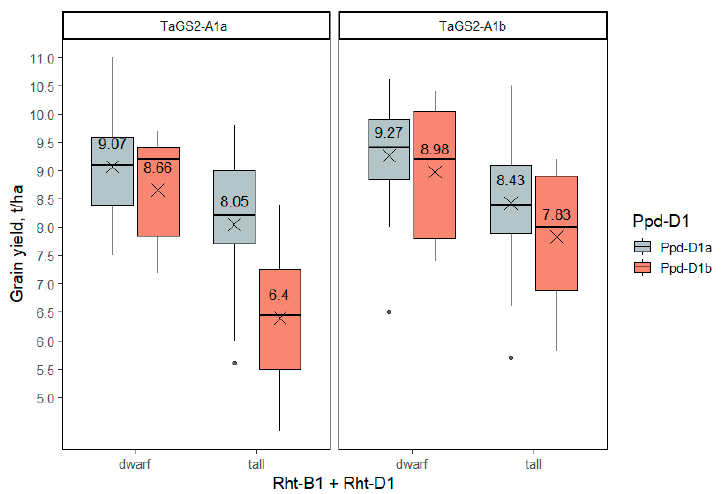
Figure 5. The grain yield of wheat accessions differing in genotypes of the three groups of genes— Rht-B1 + Rht-D1 , Ppd-D1 , TaGS2-A1 . The dots indicate outliers.